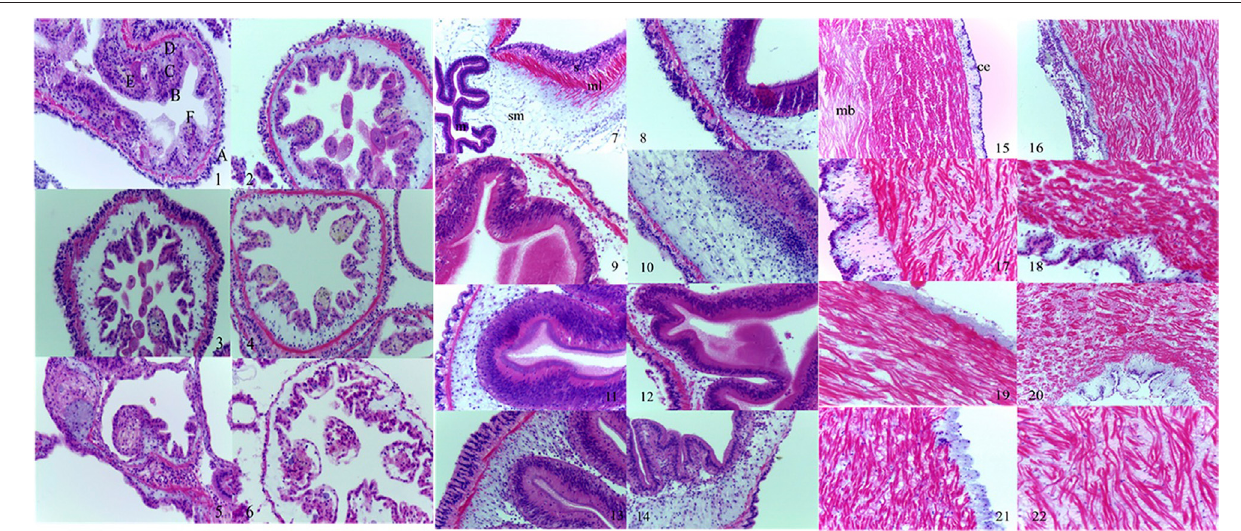
FIGURE 1 | Morphological alterations of the respiratory tree, intestinal tract, and longitudinal muscle of A. japonicus induced by semicarbazide. Note: 1. control group, × 400; 2. 20% LC 50 group 4 days, × 400; 3. 4% LC 50 group 10 days, × 400; 4. 4% LC 50 group 28 days, × 400; 5. 2% LC 50 group 14 days, × 400; 6. 20% LC 50 group 14 days, × 400; (A: upper cavity; B: endothelial cells; C: blood cavity; D: muscular layer; E: cell secretions; F: central cavity for respiratory tree); 7. control group, × 400; 8. 20% LC × 400; 9. 20% LC × 400; 10. 4% LC × 400; 11. 4% LC × 400; 12. 2% LC 50 group 2 days, 50 group 14 days, 50 group 6 days, 50 group 14 days, 50 group6 days, ×